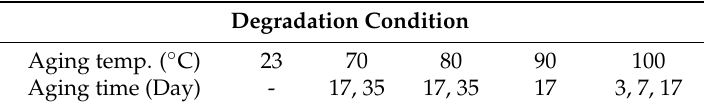
Table 1. Accelerated degradation conditions for rubber